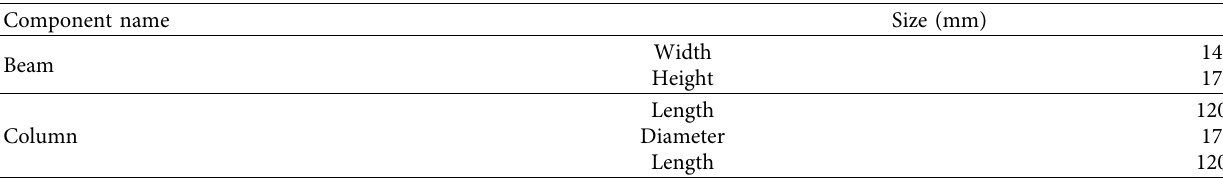
Table 3: Sizes of beams and columns.